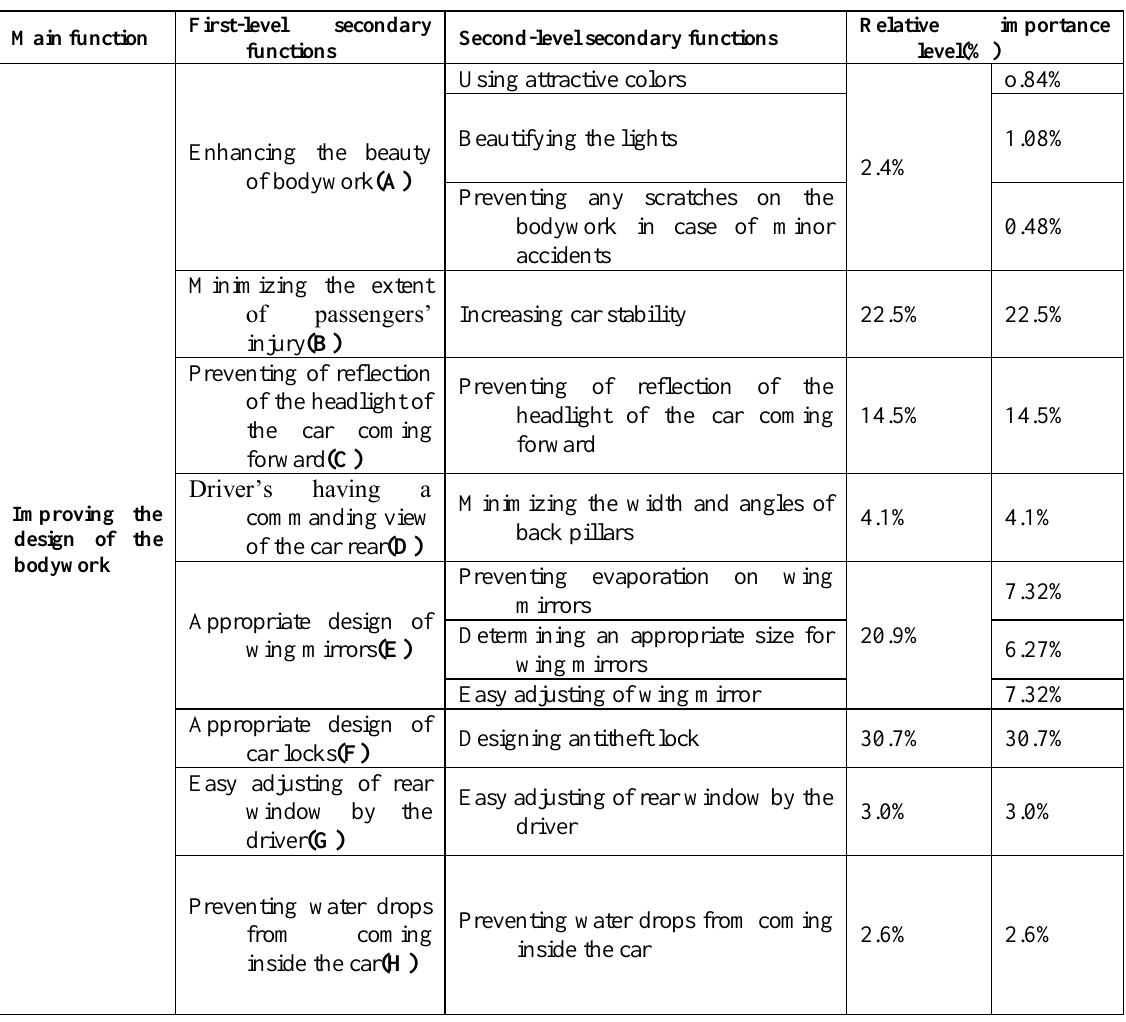
Figure 5. The relative importance of